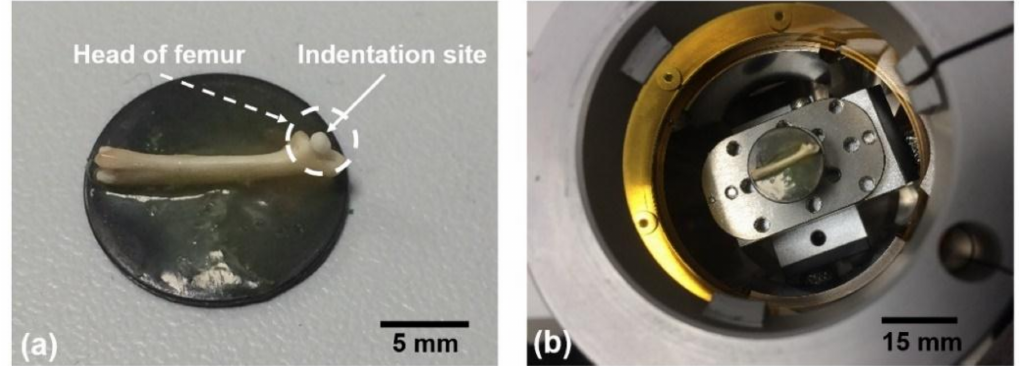
Figure 1. ( a ) Bone mounted on a steel plate with the femoral head pointing vertically for indentation, ( b ) Specimen mounted within the Hysitron in-situ nanomechanical testing rig.